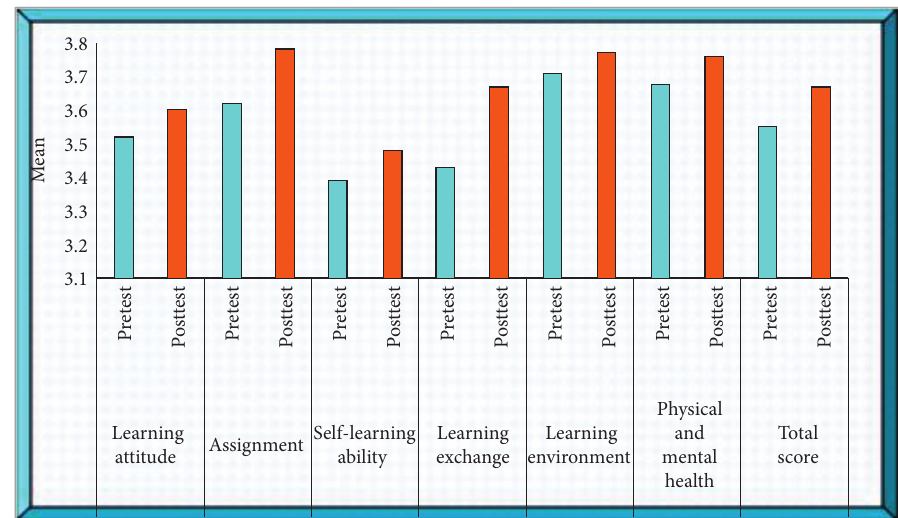
Figure 3: Changes in the average level of students’ learning adaptability based on the computer engineering education model.